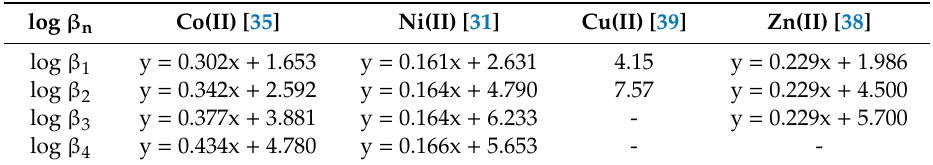
Table 2. The stability constants (log β n ) of Co(II), Ni(II), Cu(II), and Zn(II) complexes with